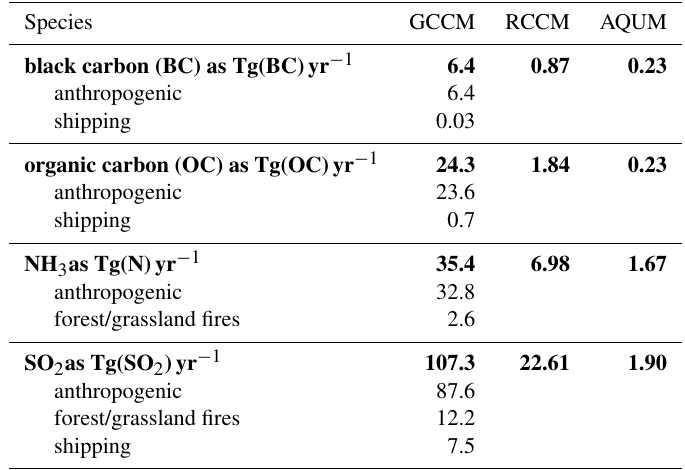
Table A4. Summary of the annual total emissions of aerosols used in the GCCM, RCCM, and AQUM models. Bold type shows the annual total for each